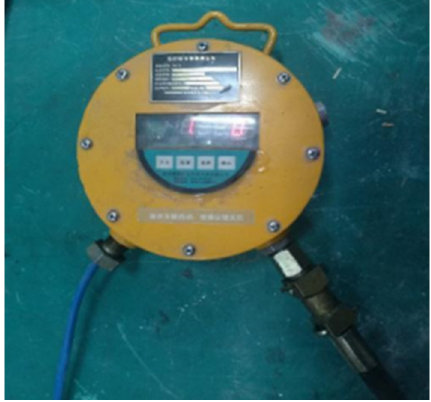
Figure 10. Comprehensive parameter tester of the CD-4 bolt.